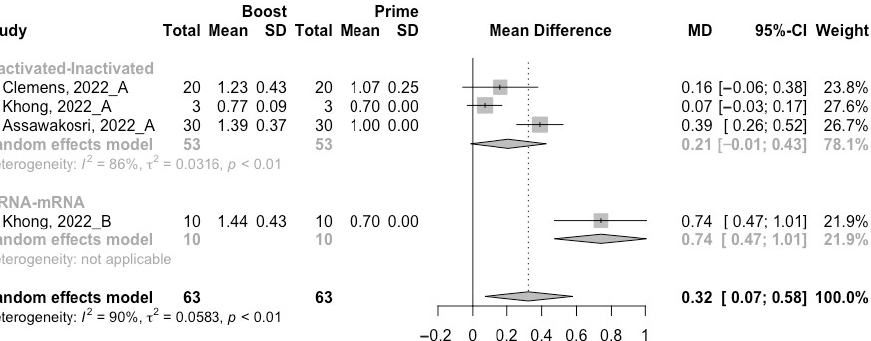
Figure 7. Forest plot of the pooled log-transformed neutralization titers against the Delta variant before and after homologous booster vaccination [2,18–32].